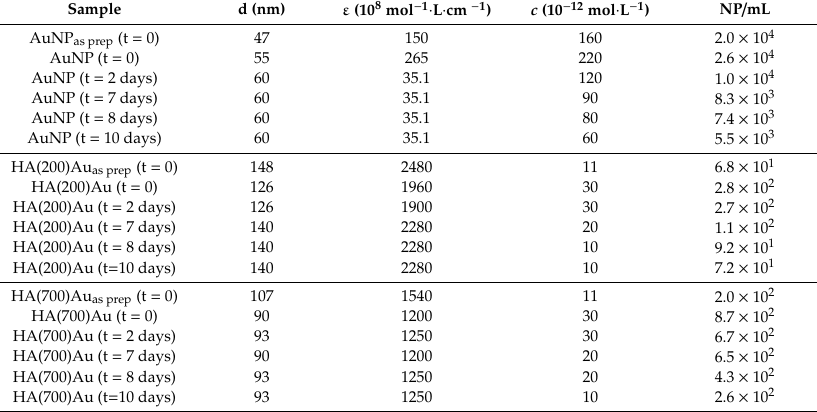
Table 3. Nanoparticle size, molar extinction coe ffi cient and concentrations for as-prepared and recovered pellets of AuNP and hybrid HA–AuNP at increasing aging times (up to t = 10